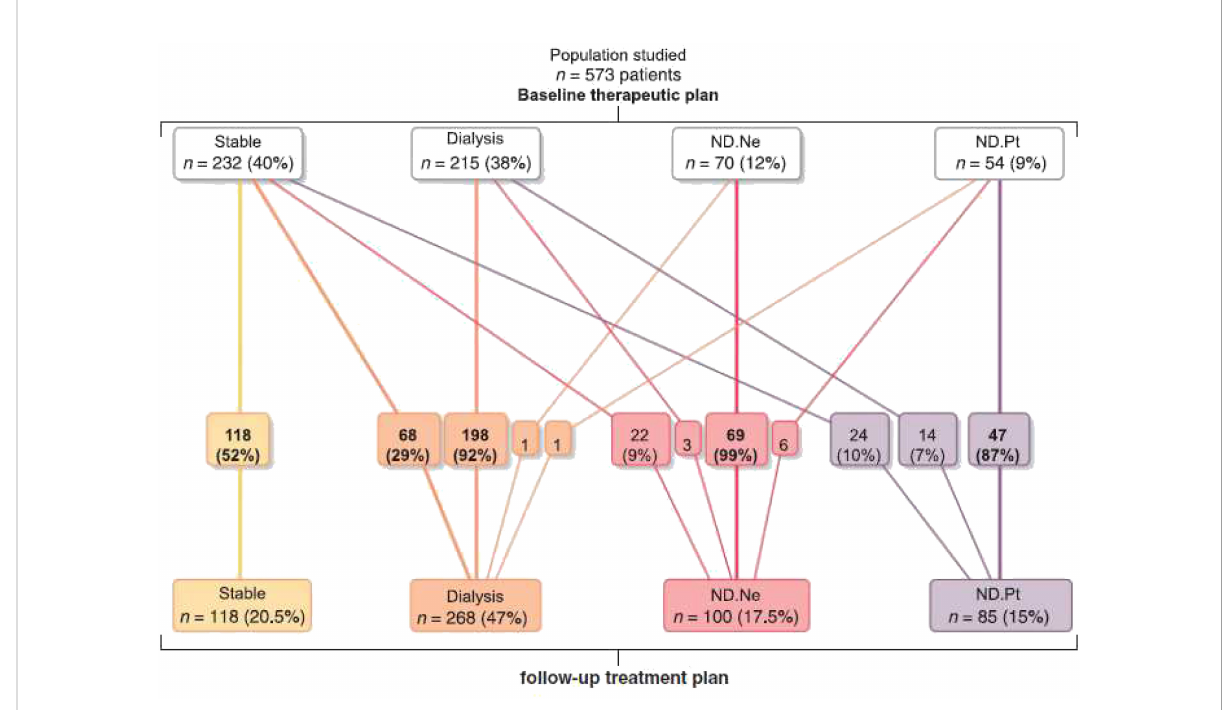
FIGURE 3 Evolution of treatment plans (source PSPA cohort). Adapted from (41,